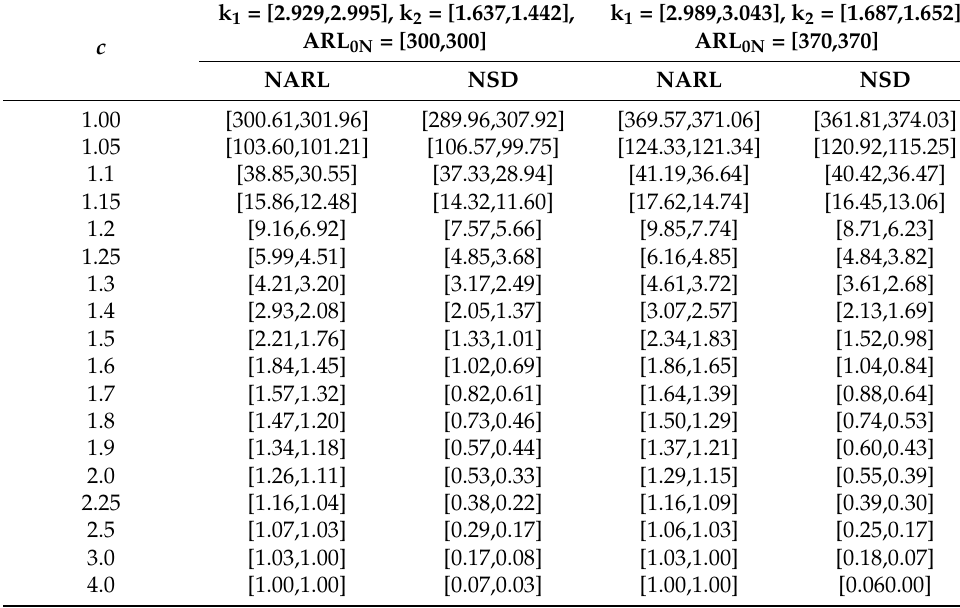
Table 5. The NARL when n N (cid:101) [8,10] and I λ U =